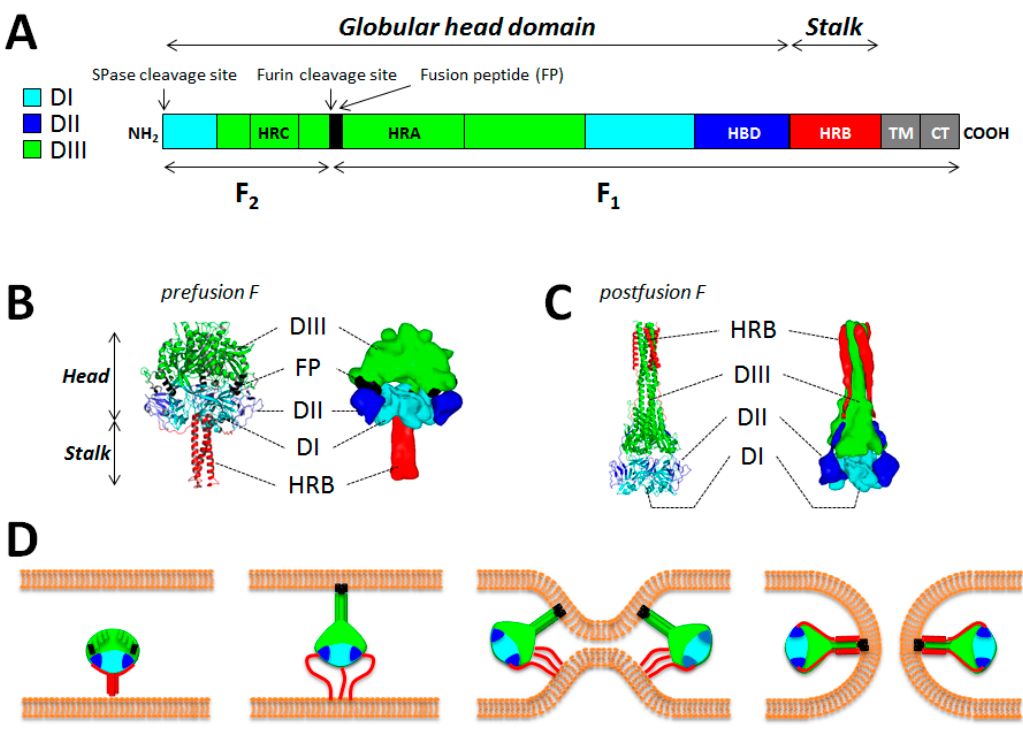
Figure 1. Structure/function of the measles virus (MeV) fusion protein. ( A ) The important functional domains of F are color ‐ coded. The F 1 and F 2 subunits are shown. While the DI (light blue), DII (dark blue) and DIII (green) domains define the globular head domain, the HRB region defines the stalk. TM: transmembrane domain; CT: cytoplasmic tail; HRA ‐ C: heptad repeat region A–C; FP: fusion peptide; HBD: H ‐ binding domain; SPase: signal peptidase. ( B and C ) Structural differences between the pre and postfusion states of F. Images were obtained from homology models performed with the canine distemper virus (CDV) F sequence (strain A75/17) and based on the atomic coordinates of the human parainfluenza virus type 5 (hPIV5) F prefusion state (PDB 2B9B) and hPIV3 F postfusion state (PDB 1ZTM). DI, DII and DIII are color ‐ coded as indicated in ( A ). Images were generated using either the PyMol (high resolution) or Sculptor (low resolution) software packages ( D ) Model of membrane fusion induced by measles virus F. Once activated by H, prefusion F may disengage from H interaction. Then the HRB region of the stalk may melt, which consequently may enable the 11 segments positioned in the globular head to rearrange into a long three ‐ helix bundle (3HB) coiled ‐ coil. This would in turn propel the fusion peptide at the top of the 3HB and allow its insertion into the target plasma membrane. This prehairpin intermediate then collapses, which brings both membranes into close proximity. Finally, F may reach the highly stable postfusion state, which carries the six ‐ helix bundle (6HB) formed by HRA and HRB segments. This stage is thought to correlate with membrane merging and ensuing fusion pore opening. This model likely requires the concerted action of more than one F molecules. This model has been described first by Yin and colleagues [79,86].